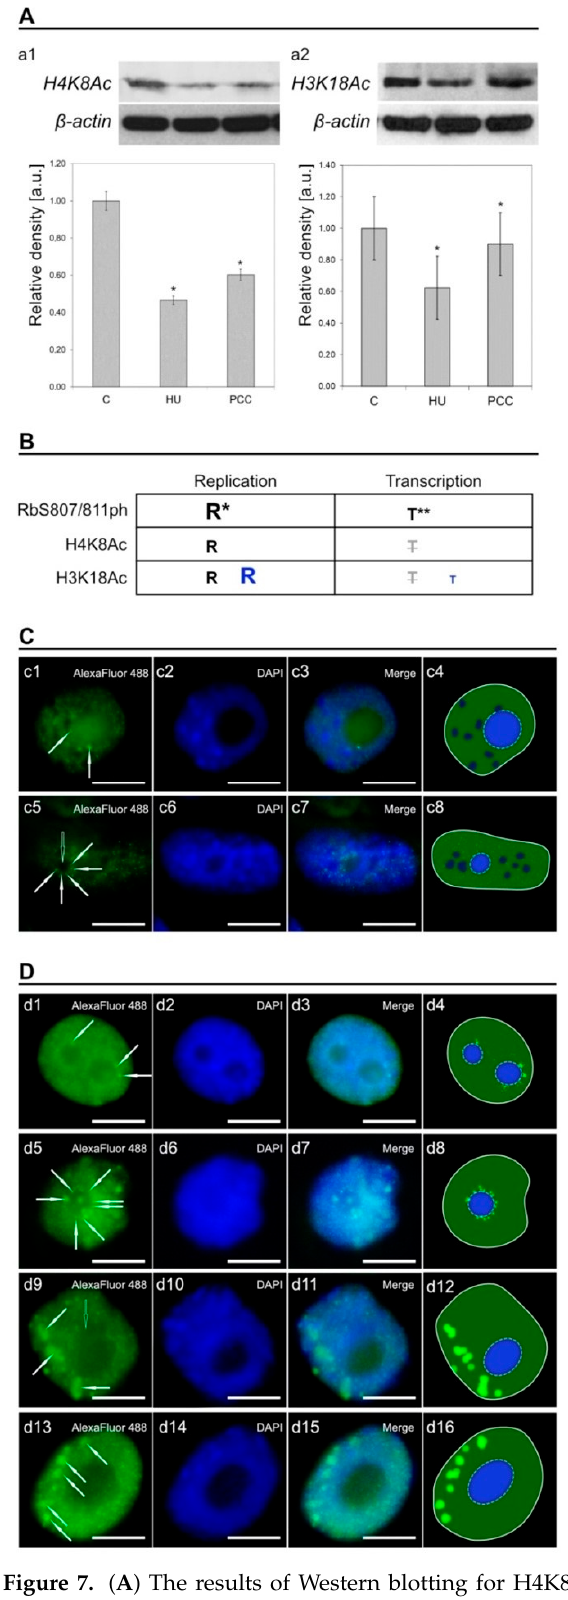
Figure 7. ( A ) The results of Western blotting for H4K8Ac ( a1 ) and H3K18Ac ( a2 ). β -actin was used as the labeling control for both histones. The density of bars is presented on the charts in arbitrary units, the control group is used as a benchmark. Stars show the significant differences between control cells and the given analyzed group. ( B ) The table summarizing the conclusions between this research (represented by black letters) and the research conducted by Jasencakova